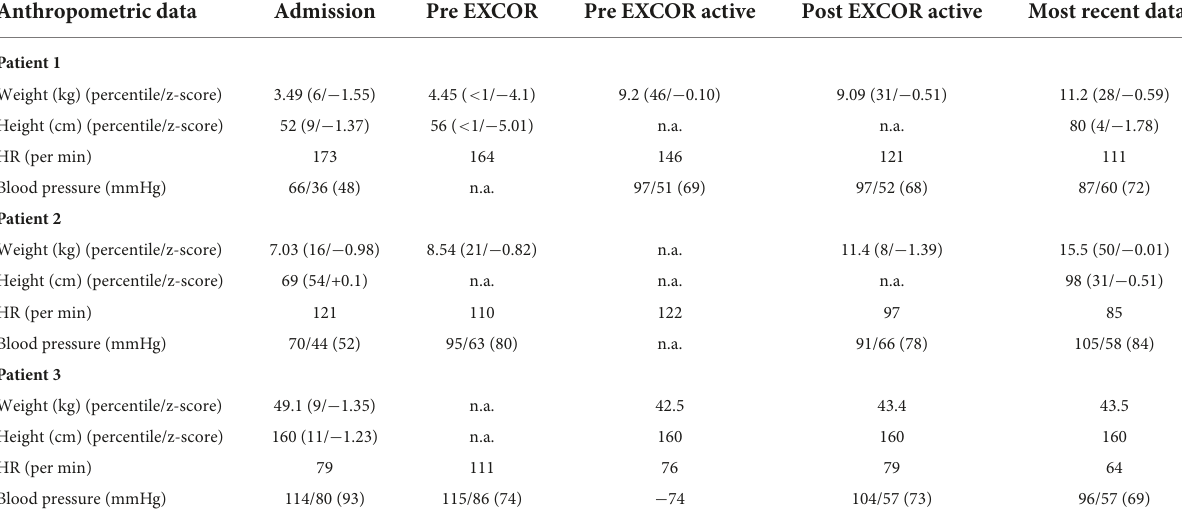
TABLE 1 Anthropometric characteristics of the patients at different stages of therapy. Anthropometric